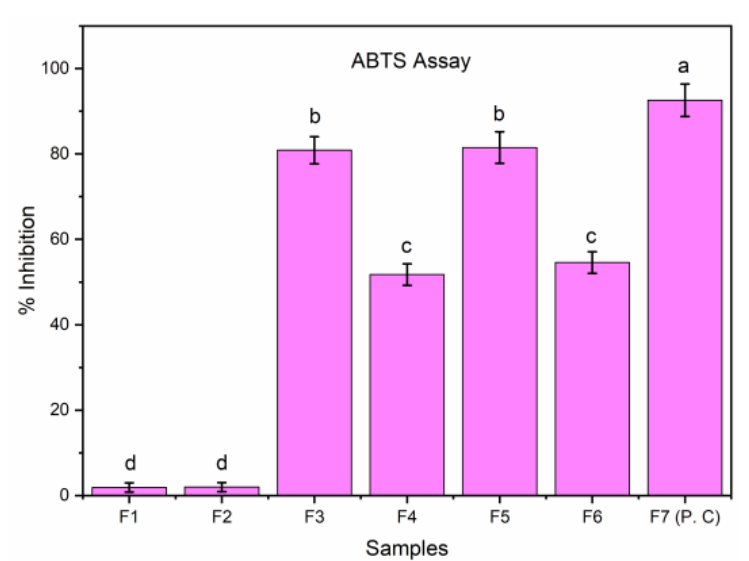
Figure 6. Antioxidant potency (ABTS) of GE-Gly blank films (F1, F2), GE-Gly-GEO films (F3, F4), GE-SA-Gly-GEO film (F5, F6), and butylated hydroxytoluene (F7). Bars correspond to mean values ± standard variations. Bar with distinct characters (a–d) reveals substantial variation between the groups ( p < 0.05).